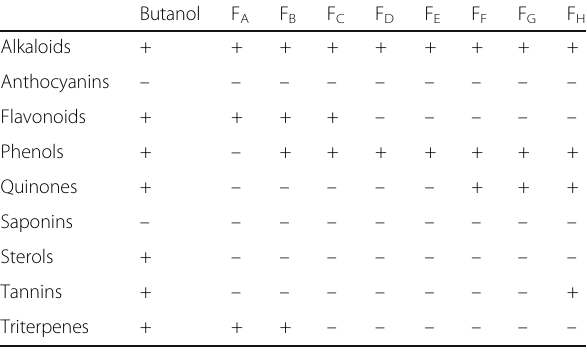
Table 2 Phytochemical composition of sub-fractions of n- butanol fraction obtained from the methanol extract of E. chlorantha stem barks Butanol